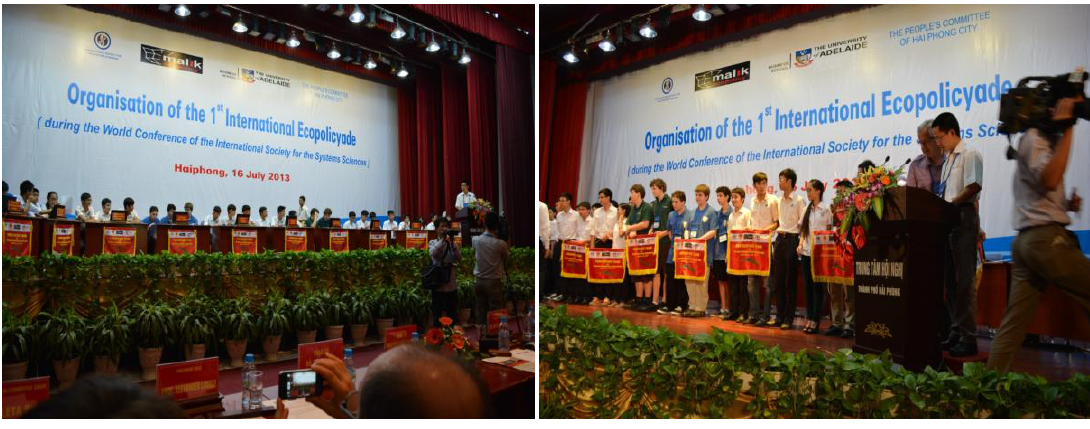
Figure 6. The First International